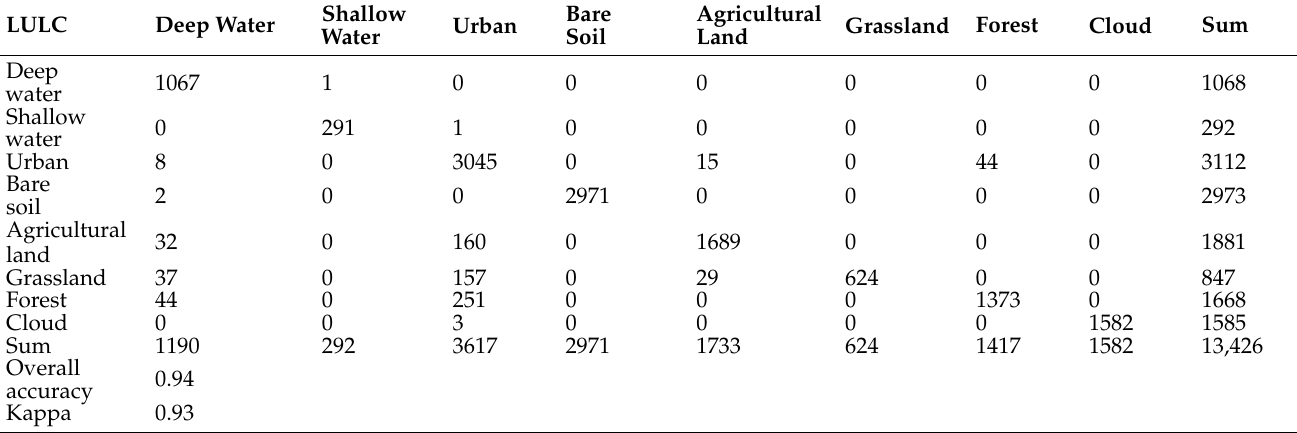
Table 8. Error matrix for accuracy assessment of LULC classification using random forest (Leeuwen et al. [48]).